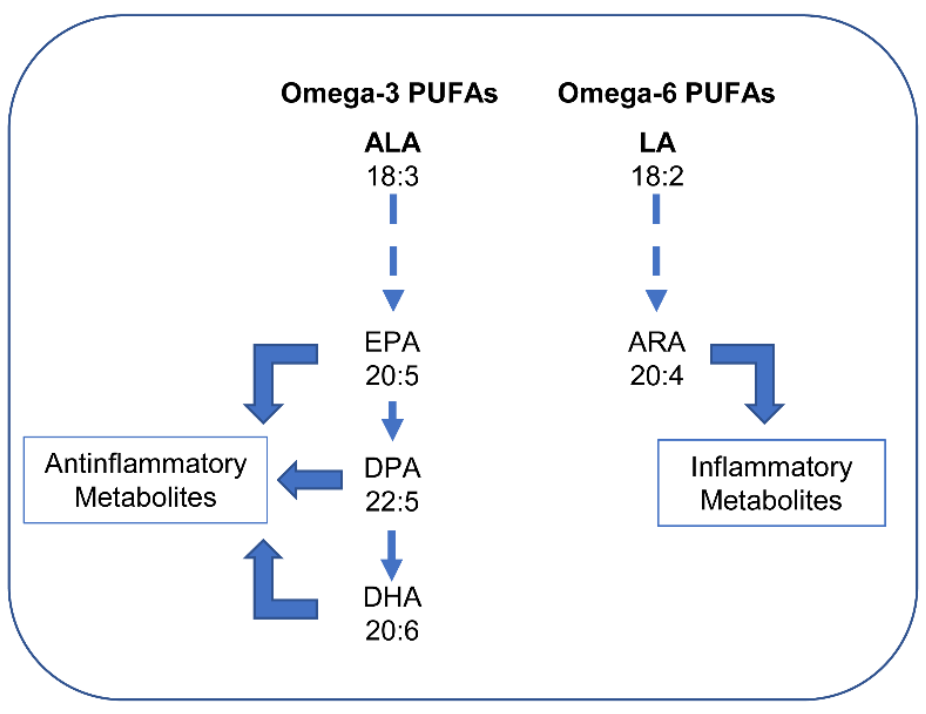
Figure 3. Synthesis of n -3 and n -6 PUFAs. ALA produces EPA, DPA, and DHA. LA produces ARA. n -3 PUFA-derived lipid metabolites largely inhibit inflammation. These mediators include resolvins and protectins. By contrast, ARA produces inflammatory metabolites (eicosanoids), which tend to promote inflammation. They include prostaglandins, leukotrienes, and thromboxanes (see [56,58]). ARA, however, also produces lipoxins that promote the resolution of inflammation (see [59]). Abbreviations: ALA, α -linolenic acid; ARA, arachidonic acid; DPA, docosapentaenoic acid; DHA, docosahexaenoic acid; EPA, eicosapentaenoic acid; LA, linoleic